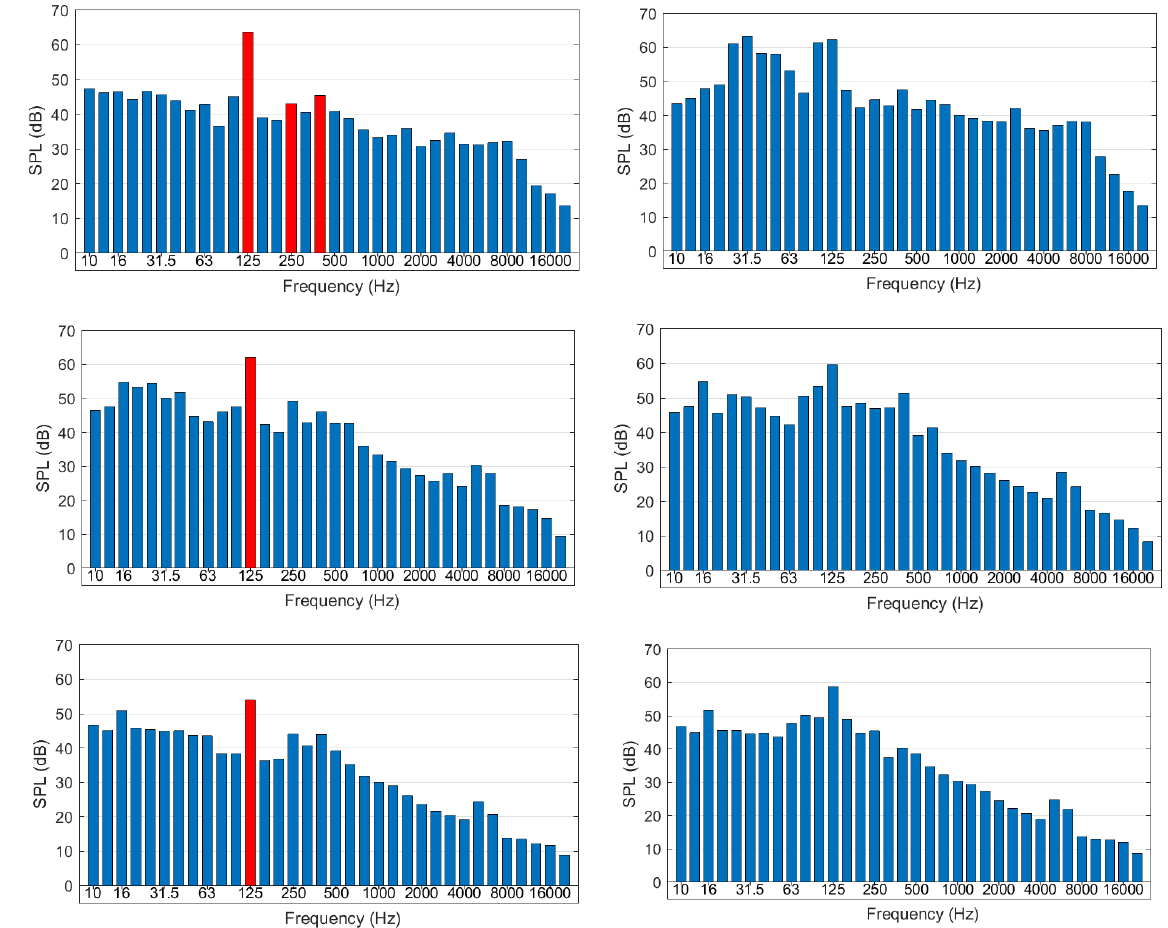
Figure 8. Sound pressure frequency spectra in the absence and presence of sound masking. The images on the left refer to spectra measured with the masking system turned off, while those on the right refer to spectra measured under the effect of the masking system. The three lines correspond to measurement points #2, #3, and #6, respectively.